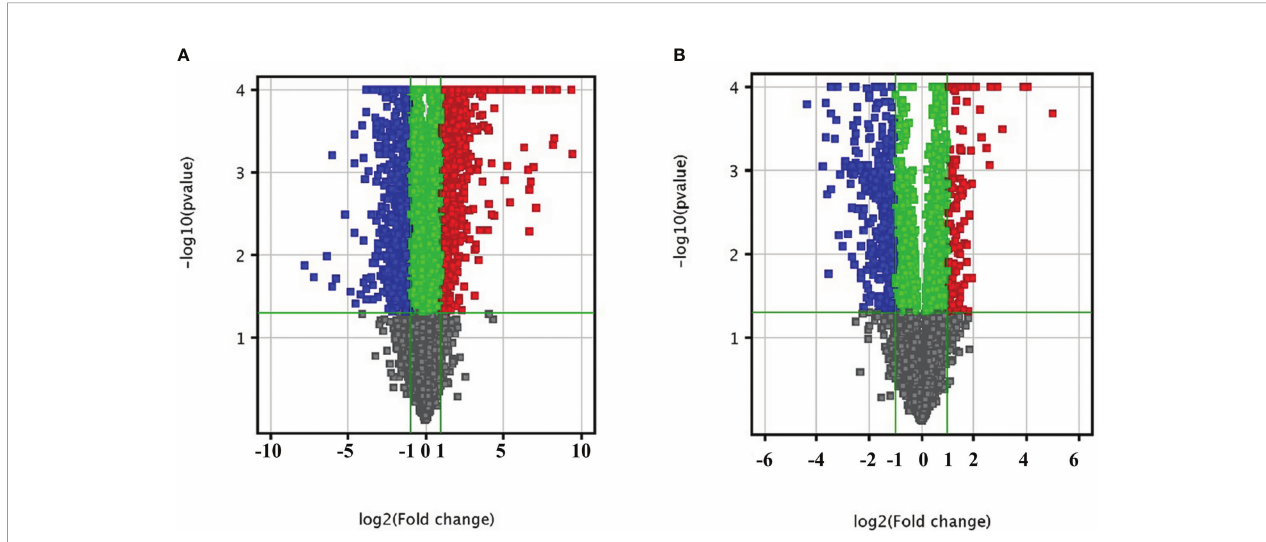
FIGURE 1 | Bioinformatics analysis of differentially expressed mRNAs (A) and lncRNAs (B) in liver tissue infected with C. sinensis . The vertical axis corresponds to the negative logarithm of p value with base 10 (-log10(p value)), and the horizontal axis represents the logarithm of fold change with base 2 (log2(fold change)). The signi fi cantly up- and downregulated RNAs are presented as red or blue squares, respectively.